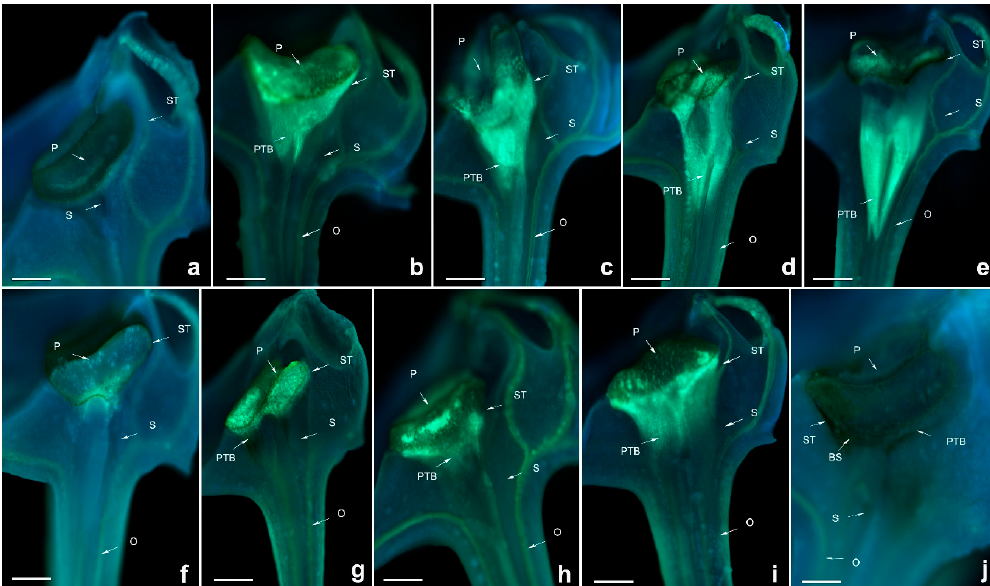
Figure 5. Growth of pollen tubes after self- and cross-pollination of Dendrobium unicum . P: pollinium; ST: stigma; S: style; BS: black spots; PTB: pollen tube bundle; O: ovary. ( a ) 24 h after cross-pollination; ( b ) 48 h after cross-pollination; ( c ) 72 h after cross-pollination; ( d ) 96 h after cross-pollination; ( e ) 120 h after cross-pollination; ( f ) 24 h after self-pollination; ( g ) 48 h after self-pollination; ( h ) 72 h after self-pollination; ( i ) 96 h after self-pollination; ( j ) 120 h after self-pollination. Bars = 100 µ